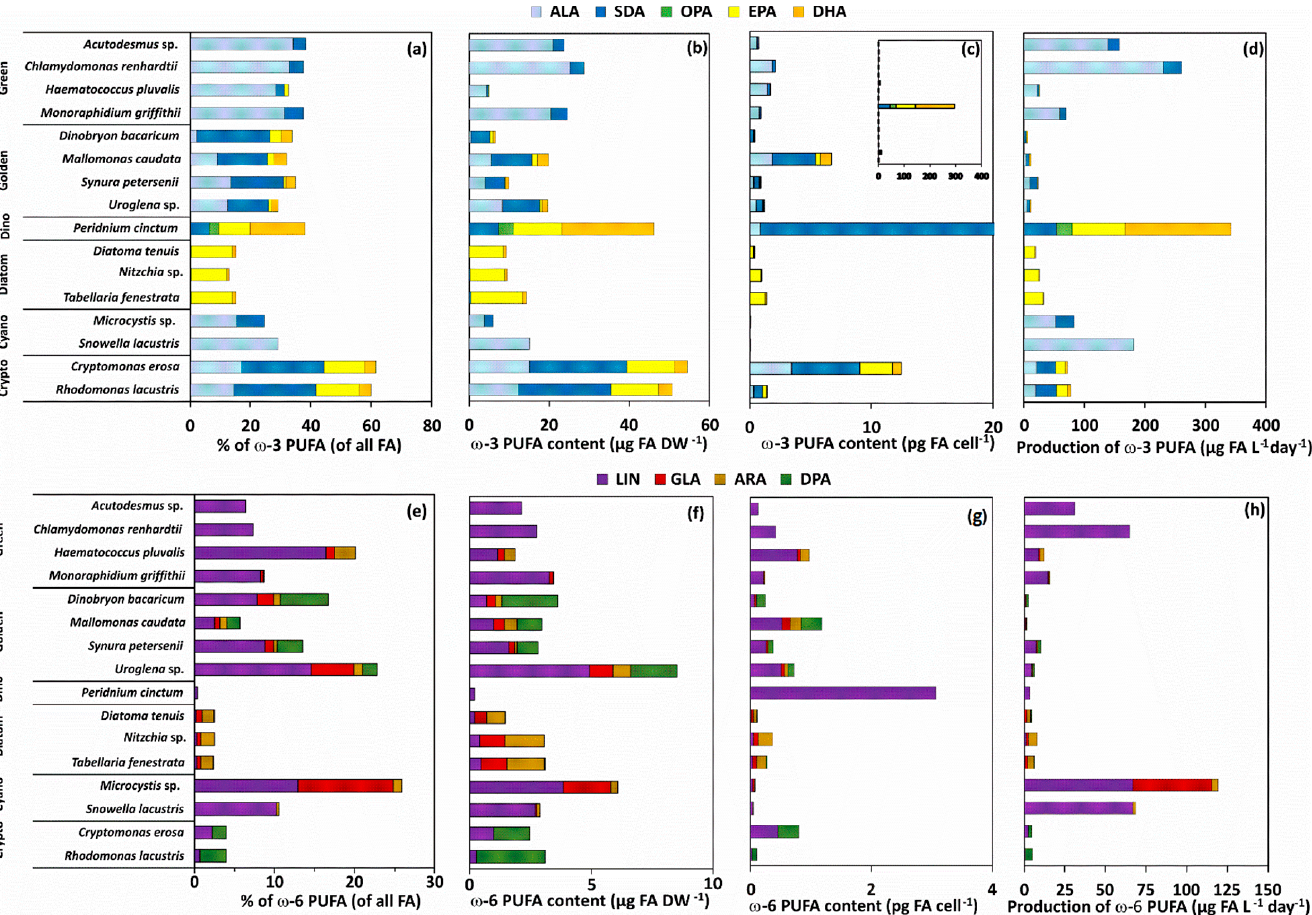
Figure 2. The proportion of all fatty acids ( a , e ), per biomass content ( b , f ), per cell content ( c , g ), and daily production ( d , h ) of ω -3 (ALA, SDA, OPA, EPA, DHA) and ω -6 (LIN, GLA, ARA, DPA) PUFA in cultured 16 phytoplankton